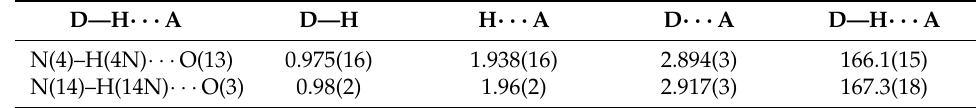
Table 3. Hydrogen bonding parameters for 1 (Å, ° ).